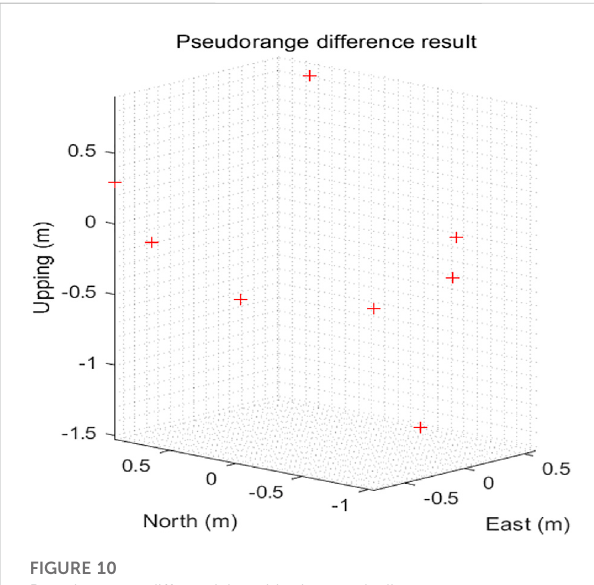
FIGURE 10 Pseudo-range differential positioning result diagram.